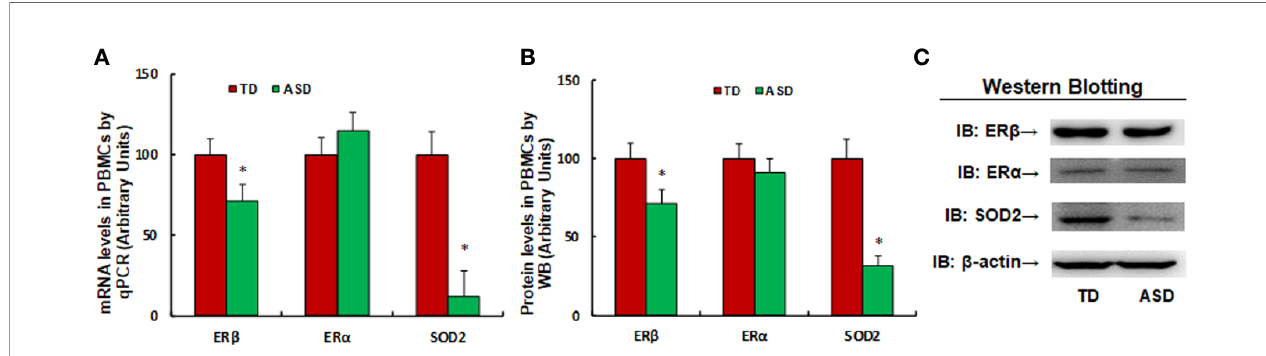
Figure S3 , the Pass/Fail Cut/Off value was set as 0.0306 for SOD2